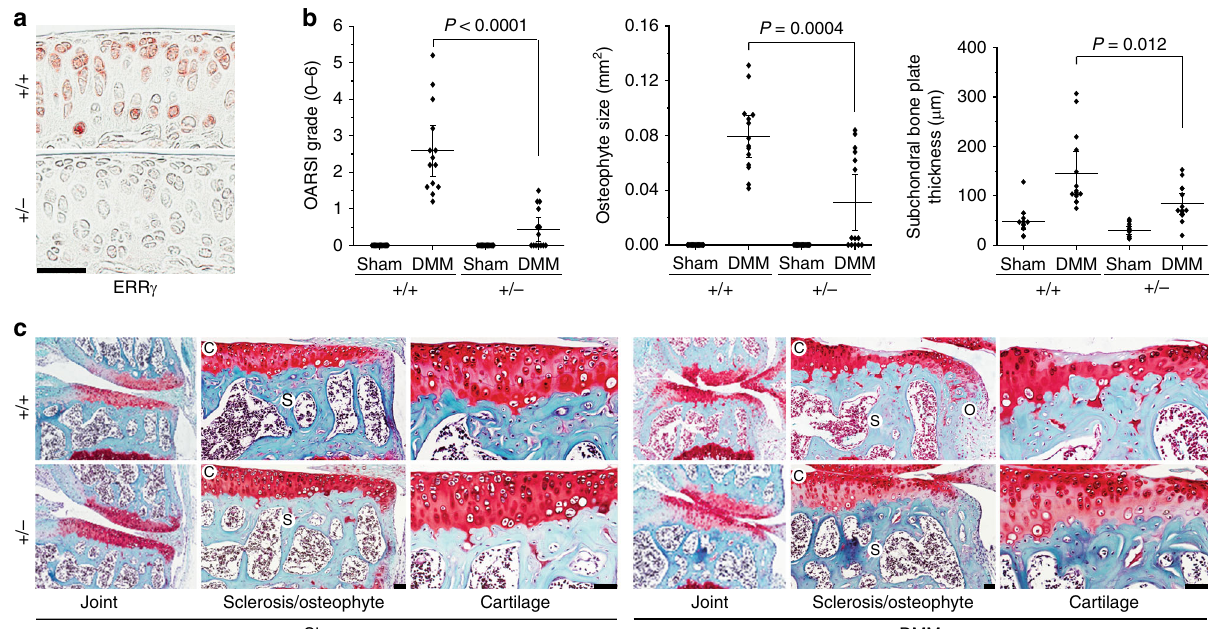
Fig. 5 Genetic ablation of Esrrg abrogates OA pathogenesis in mice. a Immunostaining for ERR γ proteins in cartilage of Esrrg + / – and WT littermates. b , c Esrrg +/ – mice and WT littermates were subjected to sham operation or DMM surgery. OARSI grade, osteophyte size, and subchondral bone plate thickness were quanti fi ed in WT and Esrrg +/ – mice ( n = 14 mice per group) ( b ). Representative images of safranin-O-stained joint sections showing the whole joint (40×), subchondral bone sclerosis and osteophyte size (200×), and cartilage (400×) ( c ). Values are presented as means ± s.e.m. Two-tailed t test and Mann – Whitney U test. Scale bar: 50 μ